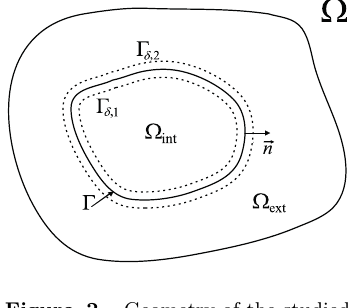
Figure 2. Geometry of the studied problem. Figure 3. The thin layer Ω δ